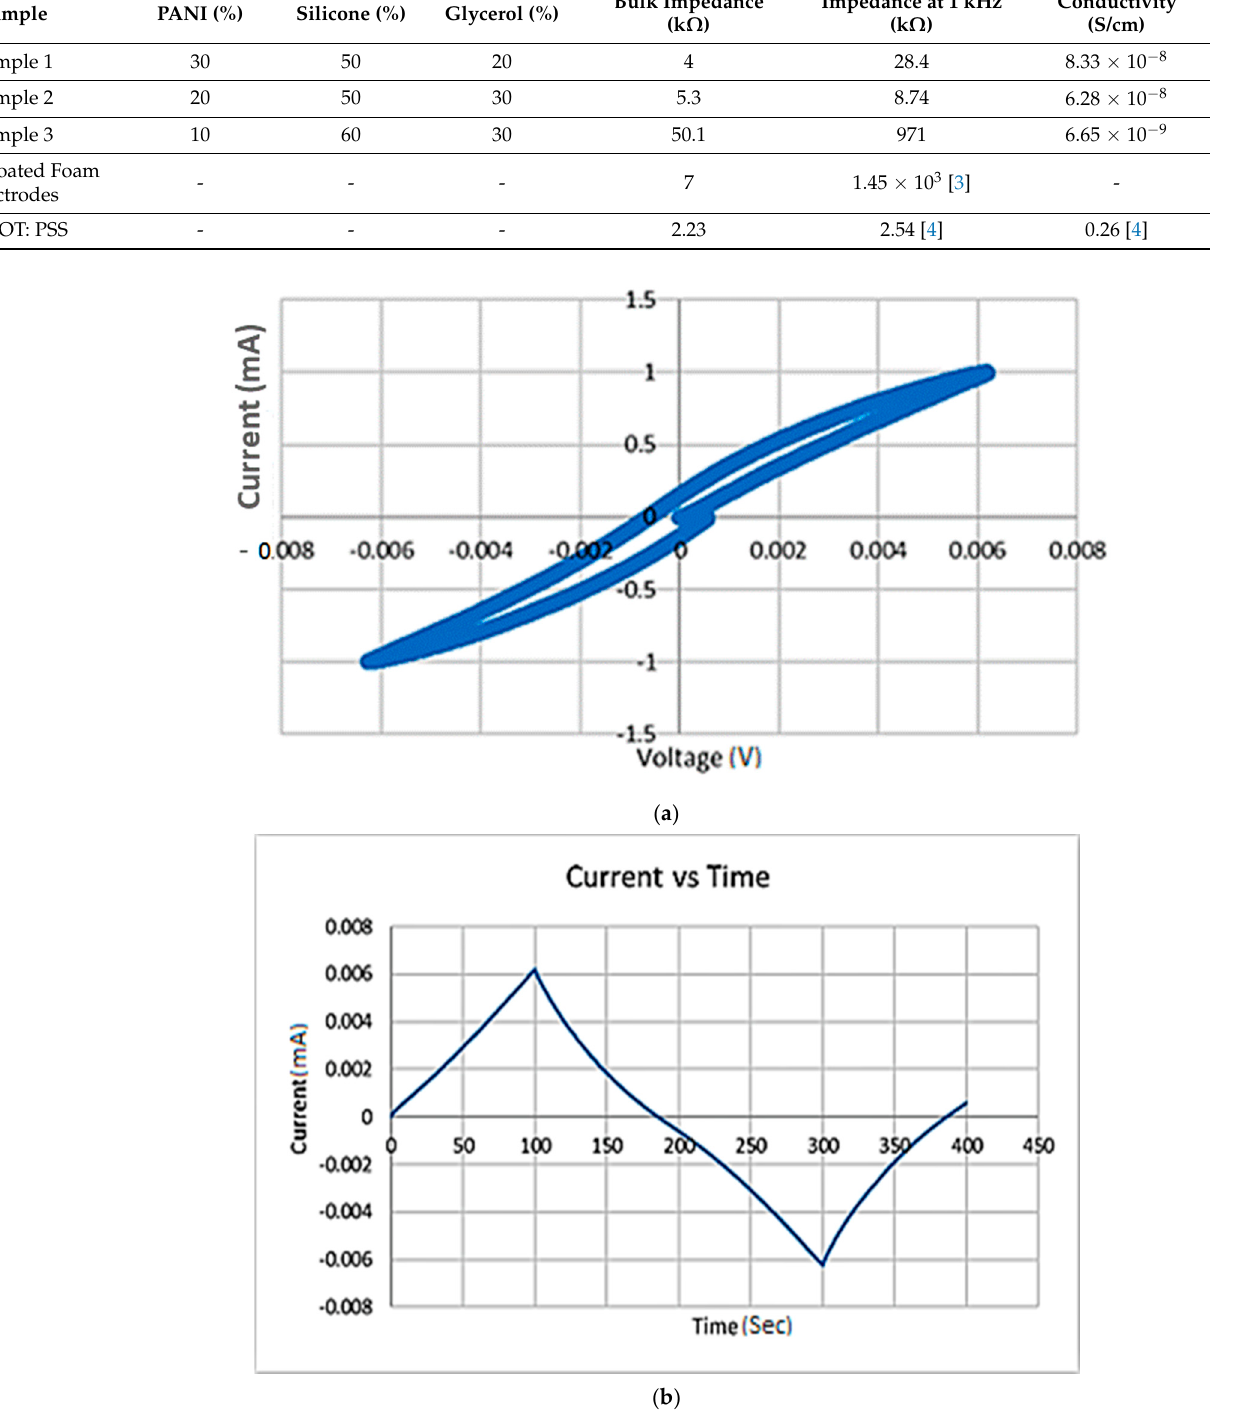
Figure 3. Cyclic voltammetry ( a ) and the relationship between current and time ( b ) for sample 1 (the best performing sample) in Table 2. The scanning rate is 10 mV/s.